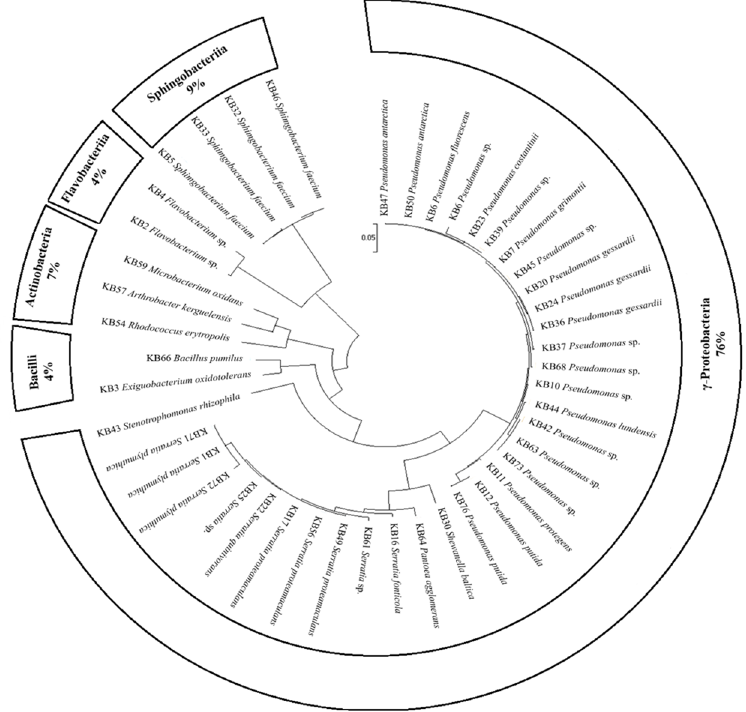
Fig 1. Maximum Likelihood phylogenetic dendrogram based on 16S rDNA sequences showing the relationship between all KB strains. Bar, 5 nt substitutionper 100 nt.